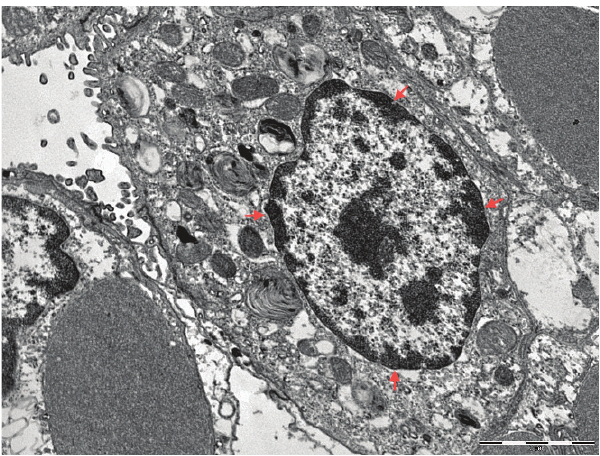
Figure 5 - Pneumocyte with a tendency for peripheral chromatin aggregation that is compatible with ongoing apoptosis (red arrows) (transmission electron microscopy, 8900X magnification).